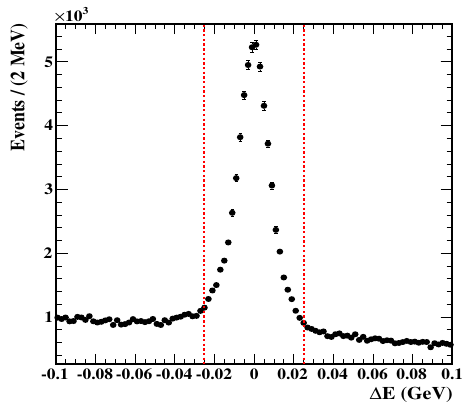
Figure 1 . (cid:1) E distribution for K 0 indicate the signal